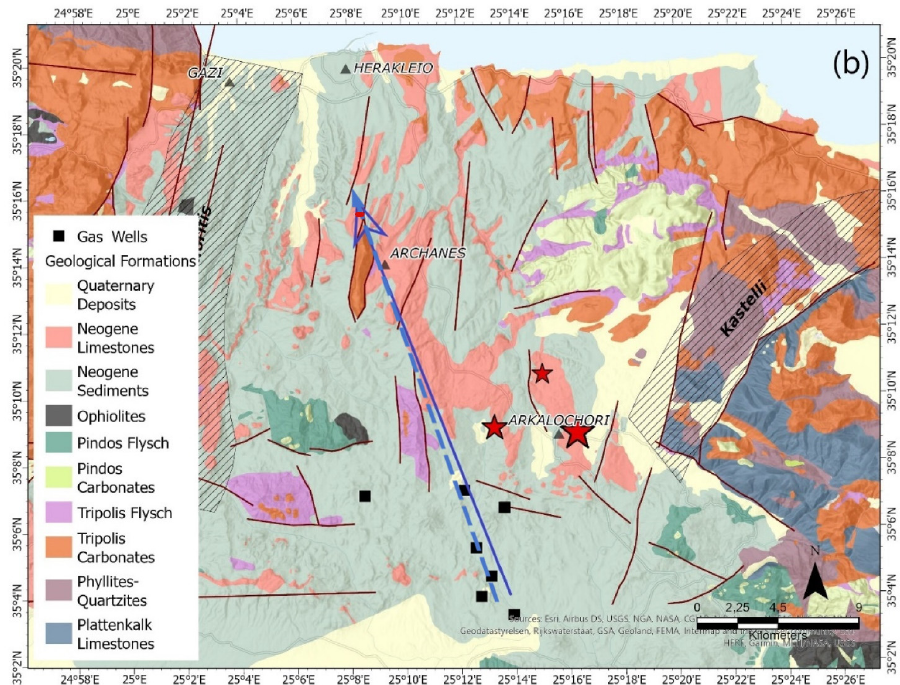
Figure 9. ( a ) Frequency of thermal anomalies combined with the wells that encountered gas, the active faults and the strongest earthquakes; and ( b ) the lithological map of the study area [64] show- ing the extended Neogene sediments and the proposed route followed by the gases before being released in the vicinity of Mount Youchtas. The epicenters of the main event and of the two major aftershocks are shown with red stars.